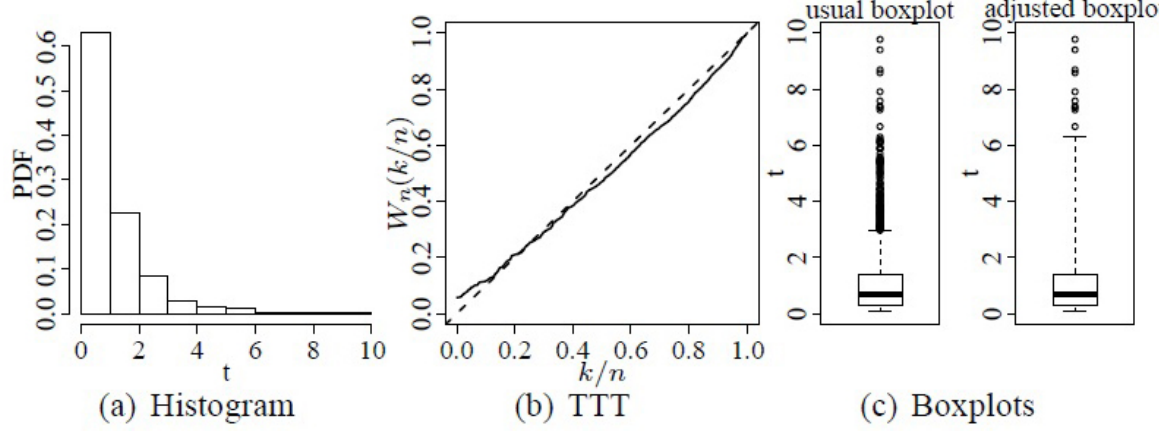
Figure 1. Histogram (left), TTT plot (center) and boxplots (right) for the BASF-SE data.